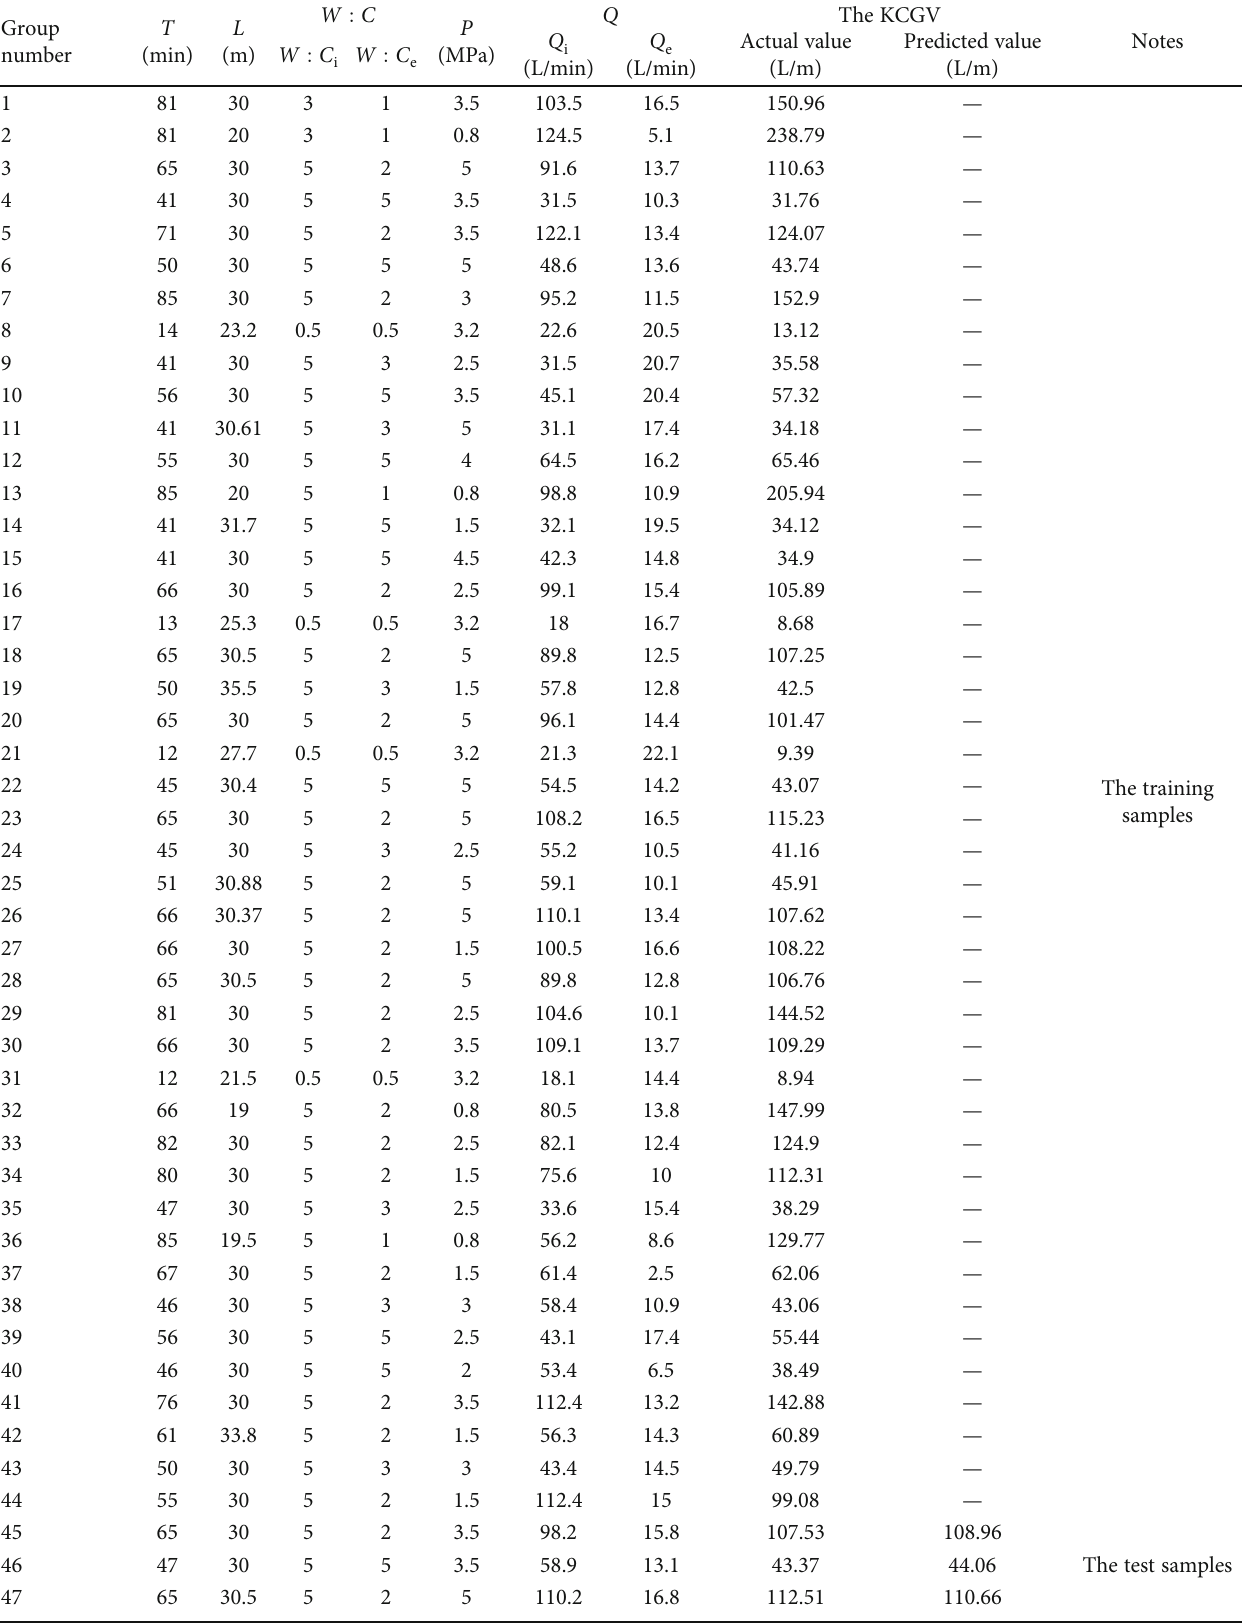
Table 1: The data set for training and